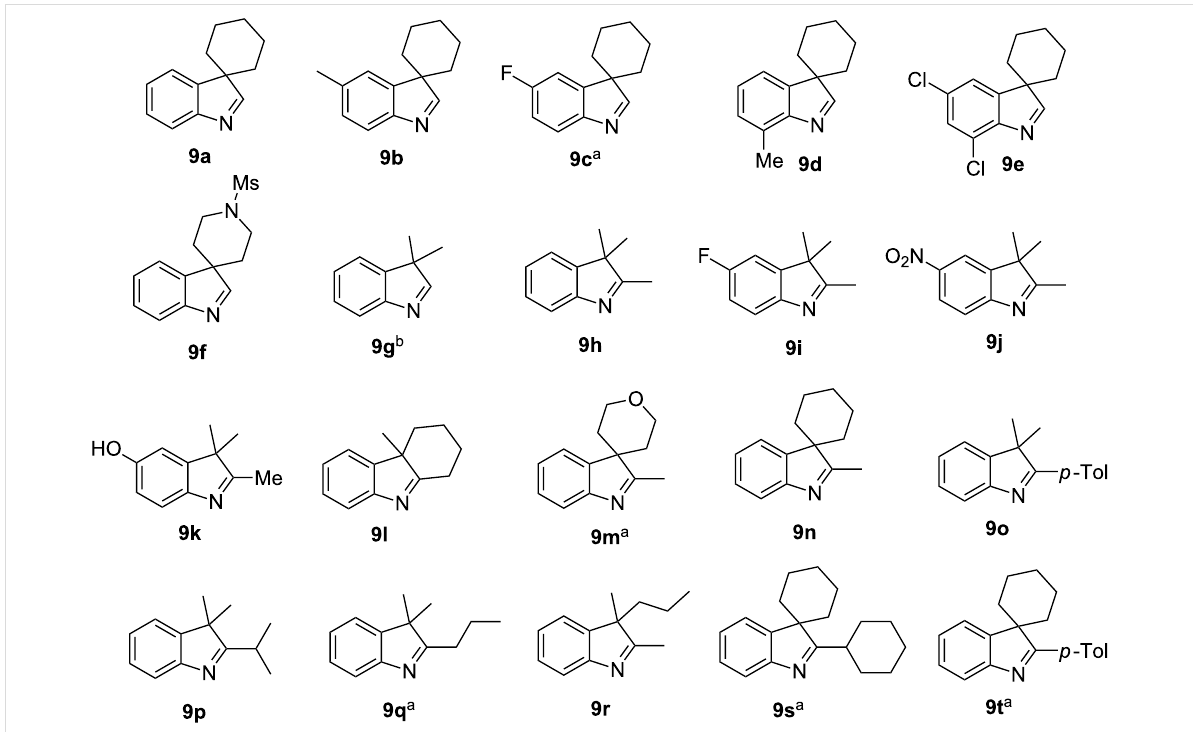
Figure 3: Indolenine substrates 9a–t investigated in this work. a Prepared for the first time (the rest are known compounds, see Experimental section). b Unstable to isolation; was taken in the CCR step as a solution in chloroform.